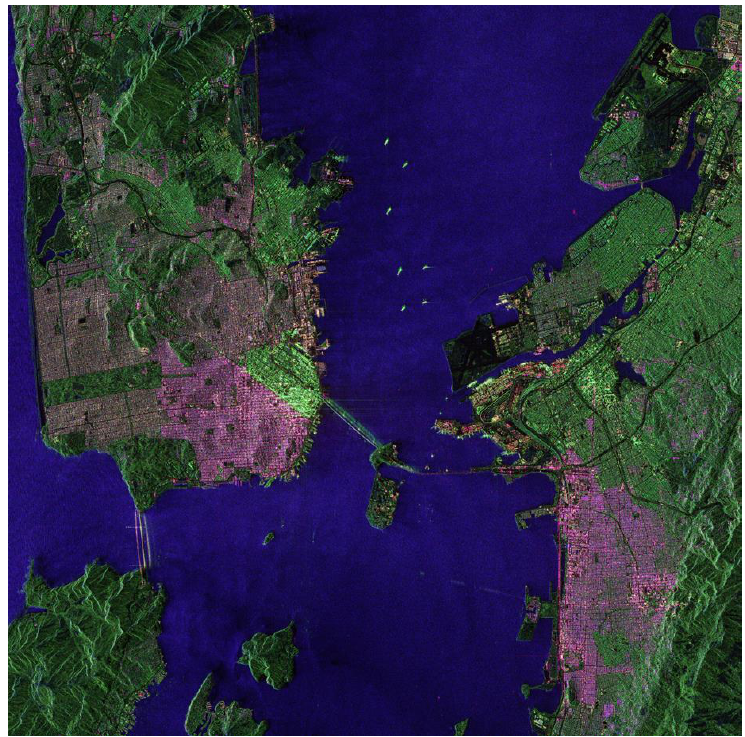
Figure 12. The GF-3 quad-pol stripmap Pseudo-colored imagery of San Francisco of America (acquired at 15 September 2017).